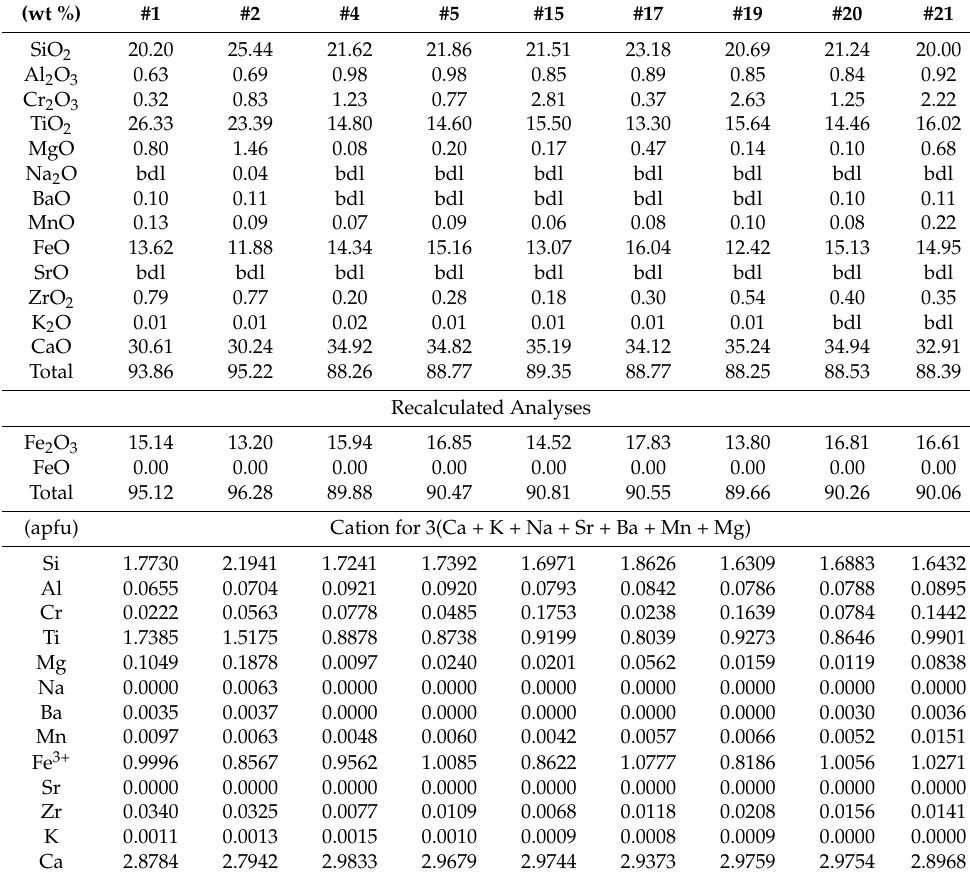
Table 2. Representative EMPA analysis of Ti-rich garnet from SK-2 kimberlites.